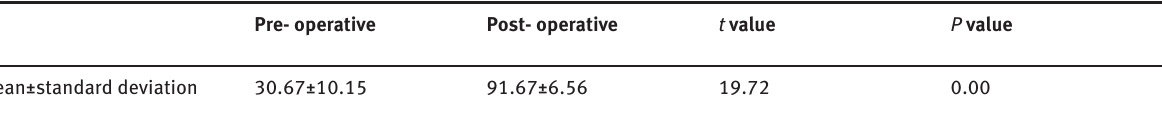
Table 4: Paired samples t test for MMW Score of pre- operative to post-